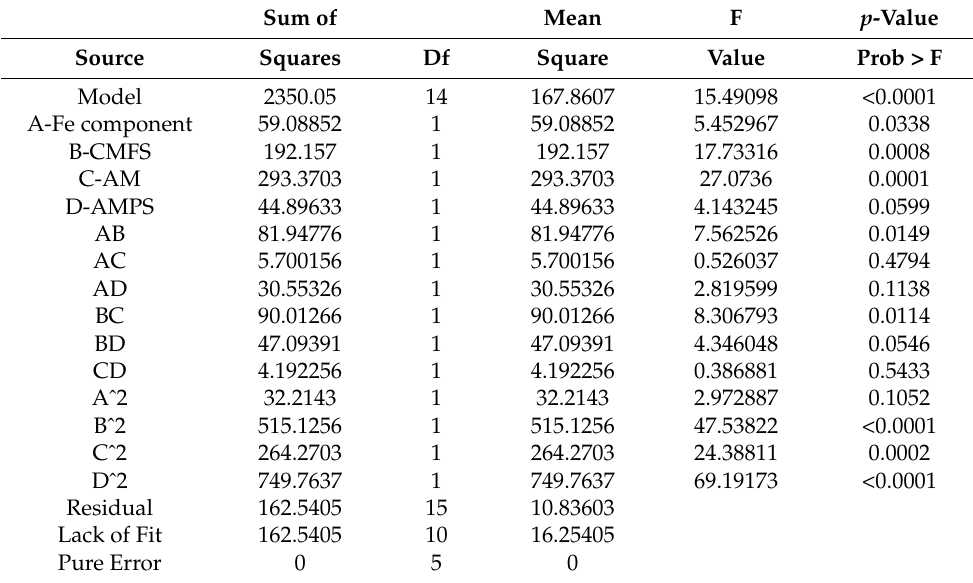
Table 2. Variance analysis of response surface model.